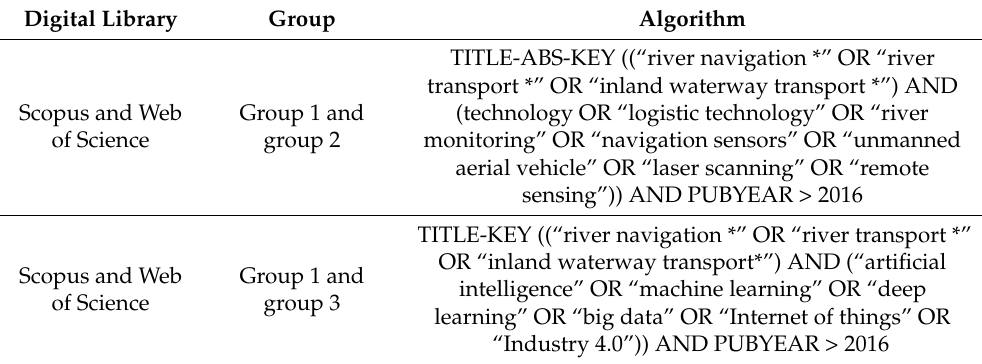
Table 3. Search query algorithms.